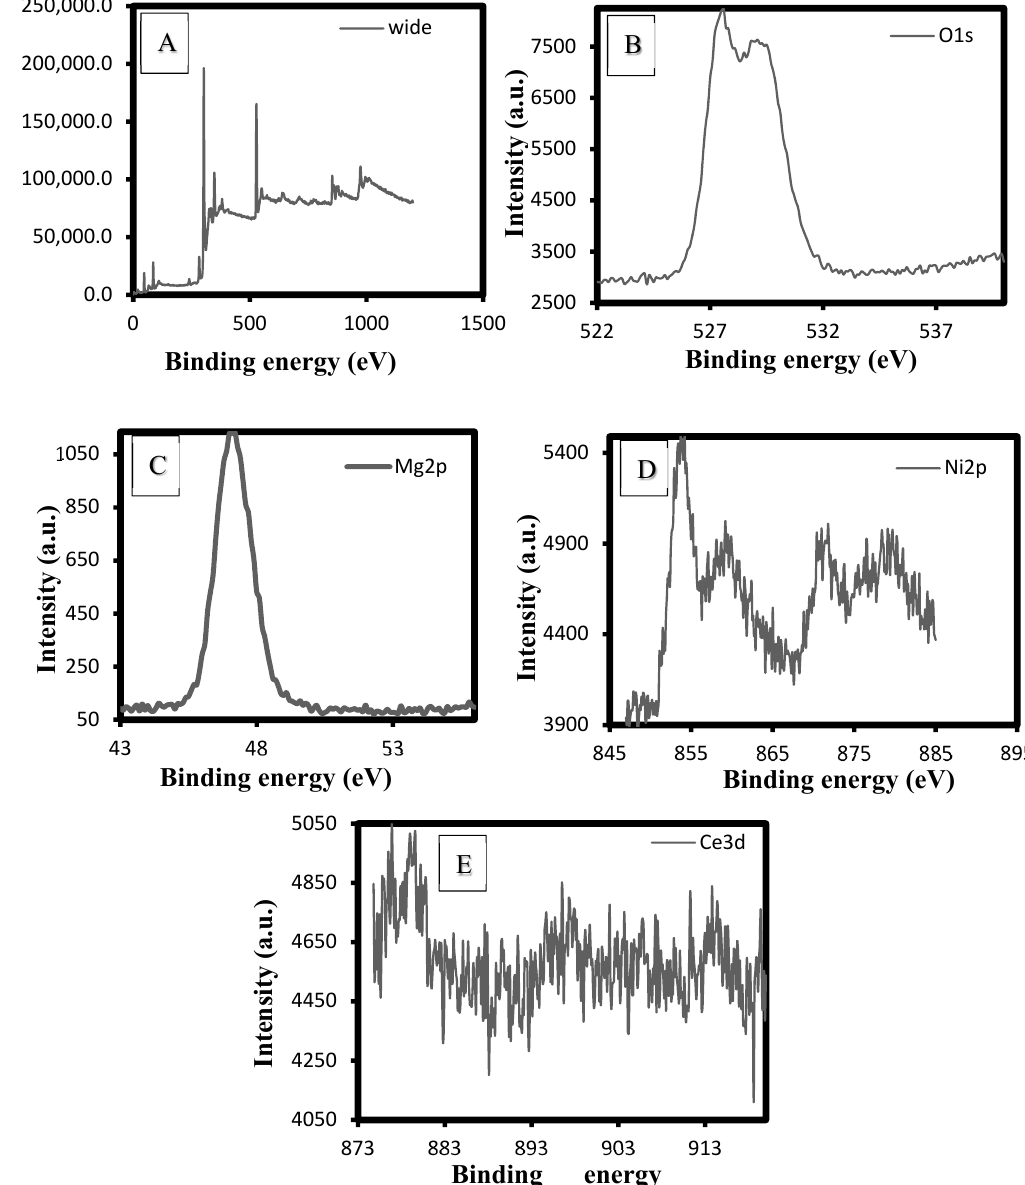
Figure 2. Narrow XPS scans of the Ni/Mg 0. 97 Ce 4+0.03 O catalyst. ( A ) Wide; ( B ) O1s; ( C ) Mg2p; ( D ) Ni2p; ( E ) Ce3d.